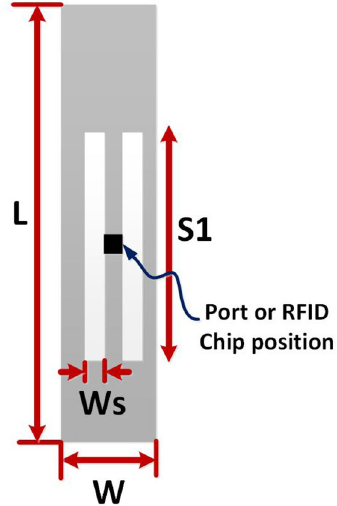
Figure 7. Different parameters of proposed tag design.